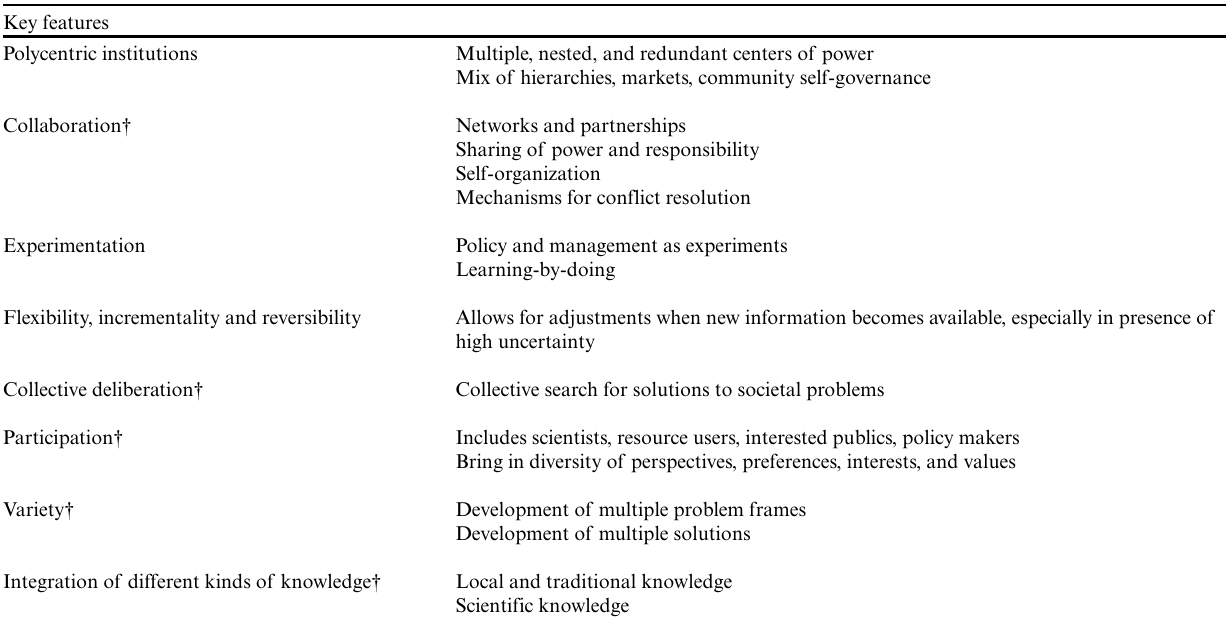
Table 1 . Key features of adaptive governance. Key